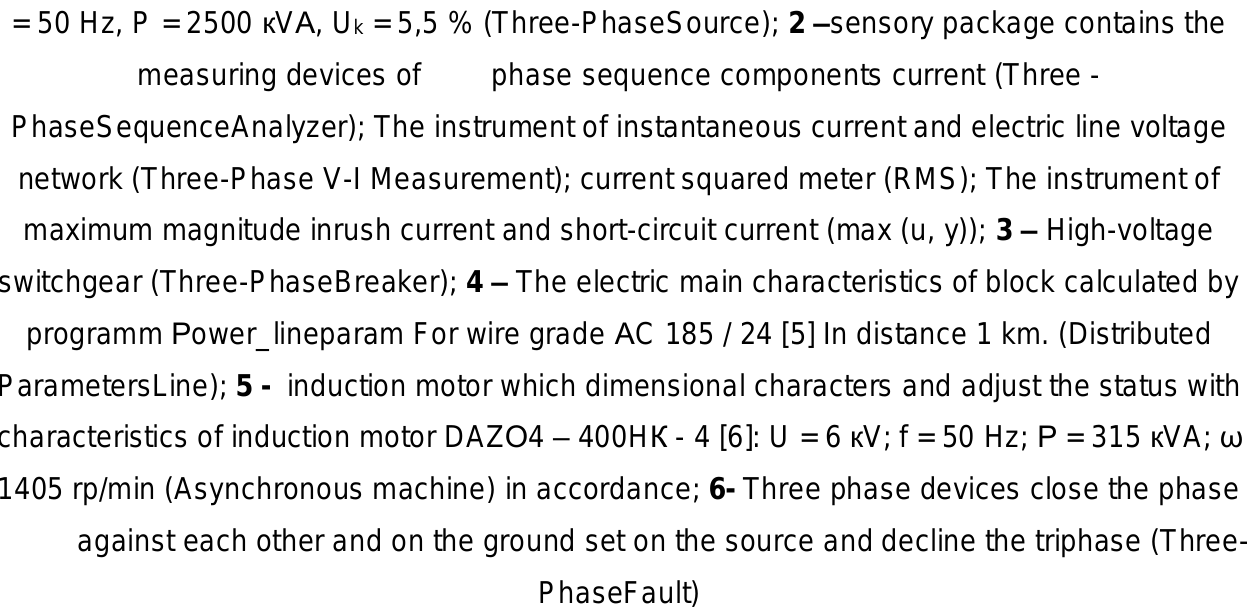
Figure 2. The model of electric system with isolated neutral: 1- three-phase power U = 6 кV, f = 50 Hz, P = 2500 кVА, U k = 5,5 % (Three-PhaseSource); 2 – sensory package contains